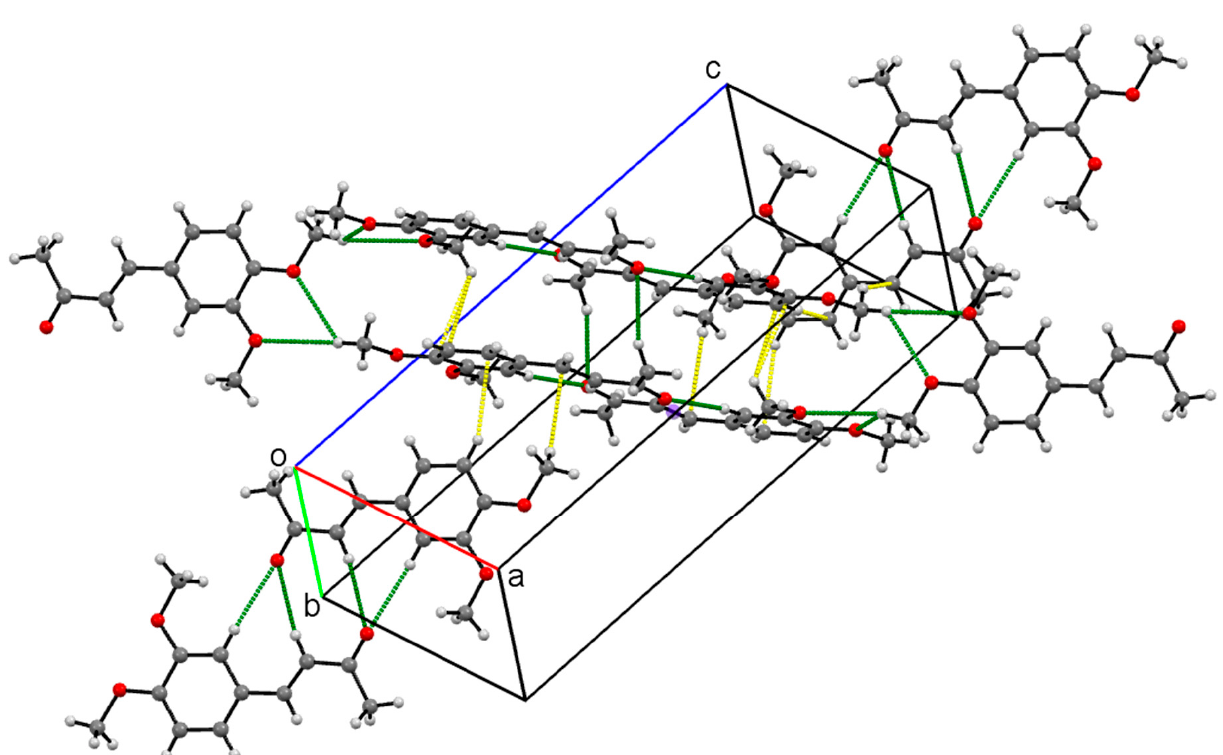
Figure 5. Packing of the crystal of compound I short contacts C–H···O (dashed green line) and C–H··· π (dashed yellow line).